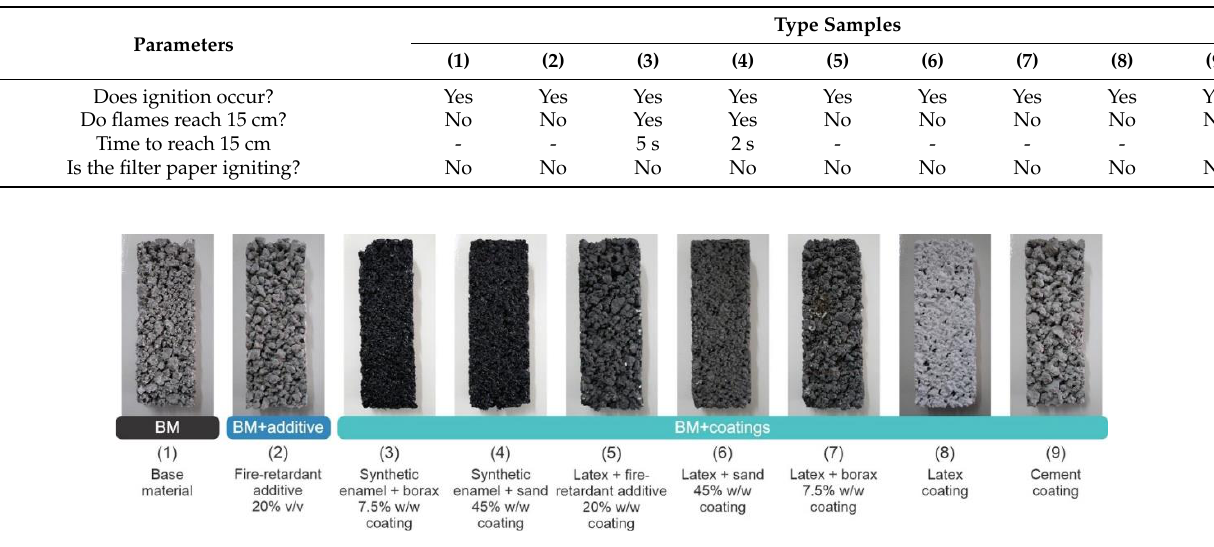
Figure 23. Compression testing of PS/cement composite material. Reprinted with permission from ref. [65]. Table 2. Sample responses to single flame source tests. Adapted with permission from ref. [66].